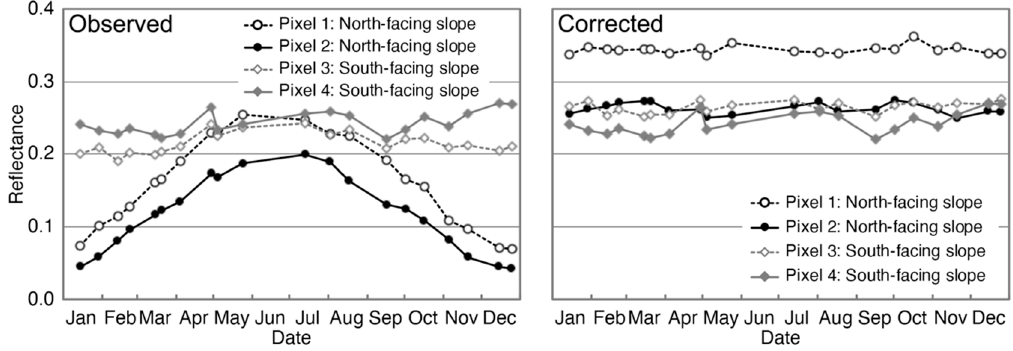
Figure 13. Time series of observed ( left ) and corrected ( right ) reflectance in the NIR band of the sample pixels over conifer trees. The pixel locations are shown in the DSM of Figure 5b.